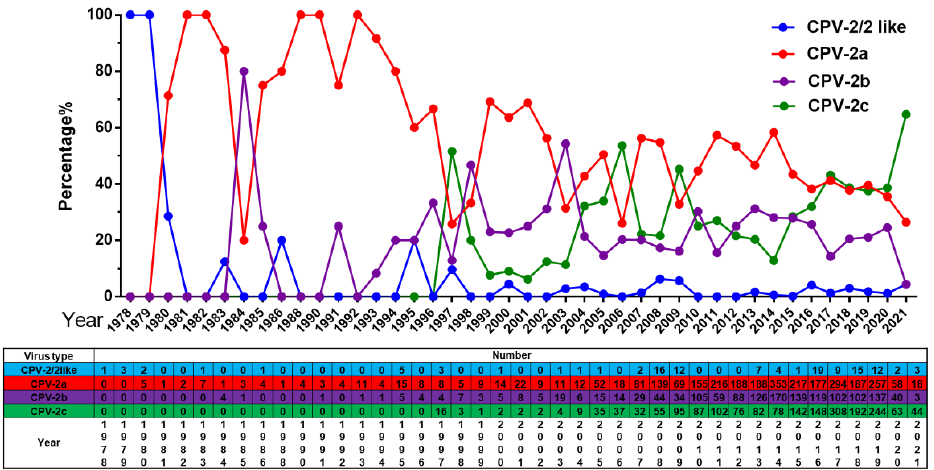
Figure 3. The number and proportion of CPV-2/2-like, CPV-2a, CPV-2b and CPV-2c in different years in the world.